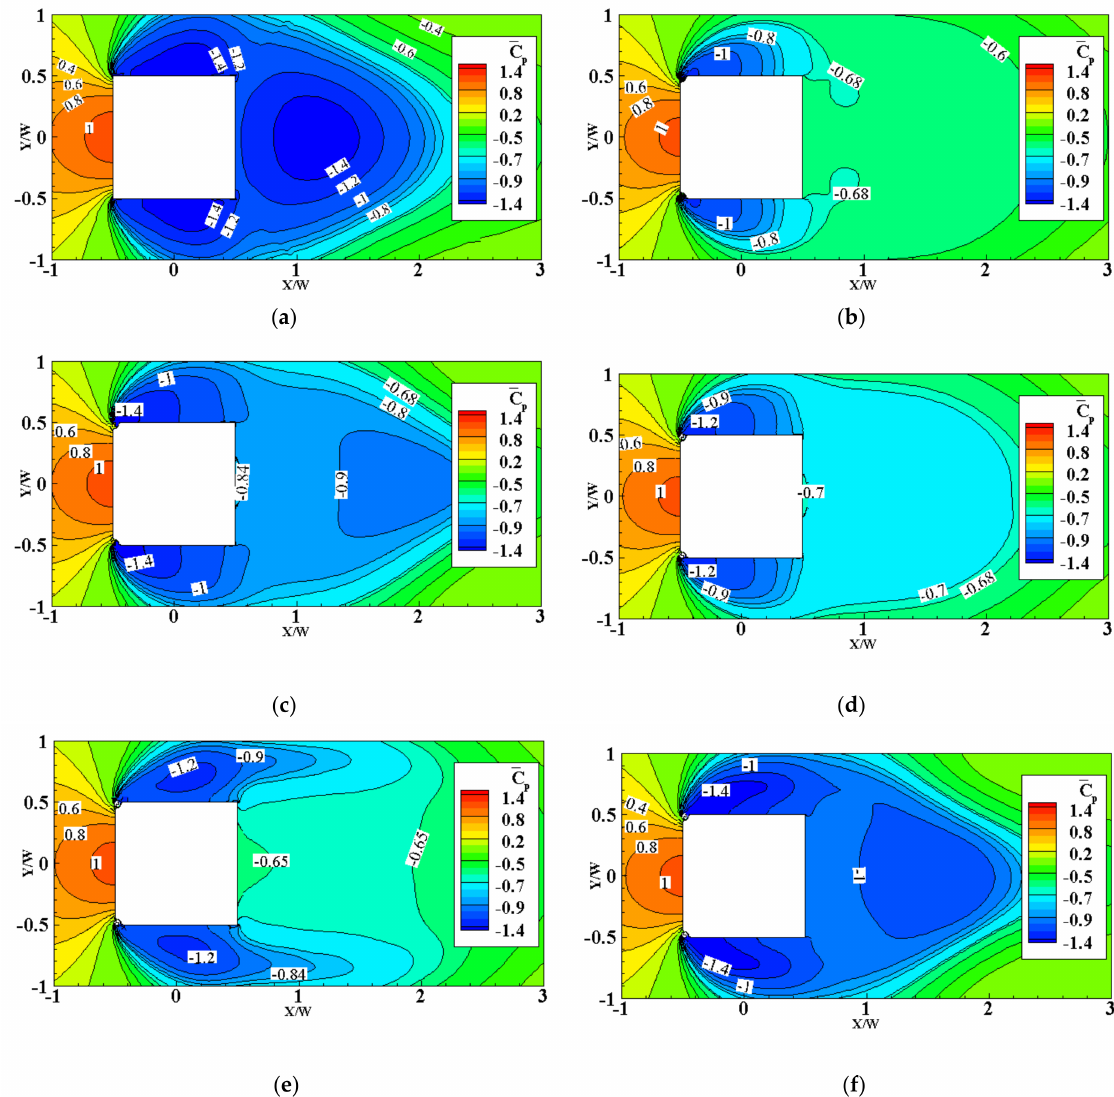
Figure 12. Time-averaged pressure coefficient distribution: ( a ) plain cylinder; ( b ) S2 ; ( c ) S4 ; ( d ) R1 ; ( e ) R6 ; ( f ) R8